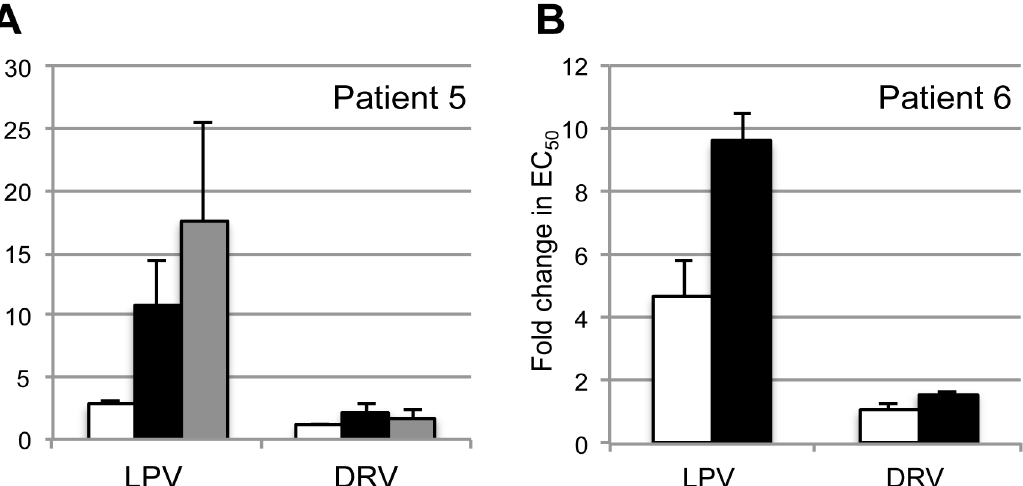
Fig 3. PI susceptibilities of pre-PI and failure virus from two patients demonstrate changes in phenotypic susceptibility over time. Full-length Gag- Protease sequences from pre-PI therapy and failure time-points was amplified or synthesised, and single round phenotypic susceptibility testing performed. PIs tested were Lopinavir (LPV) and Darunavir (DRV). (A) Susceptibility data from patient 5 demonstrates the reduction in susceptibility conferred by major mutations I84V (black) and I54V (grey) in our system in comparison with the patient virus at pre-PI therapy (white). Error bars represent standard deviation of two independent experimental repeats. (B) Virus derived pre-PI therapy (white bar) and at time of failure (black bar) from patient 6 demonstrated a difference in susceptibility to LPV in the absence of the development of major resistance mutations.